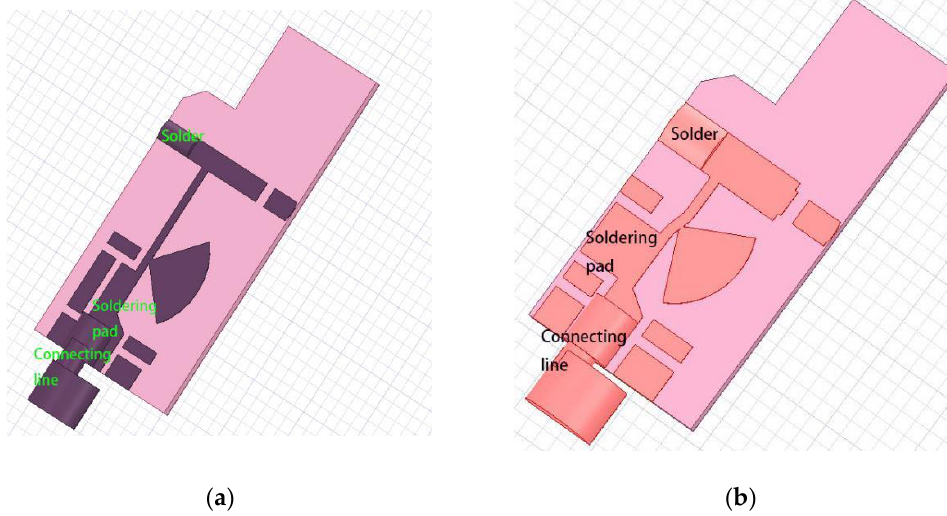
Figure 9. The simulation’s structural diagram of the traditional bias circuit and the proposed bias circuit. ( a ) The traditional bias circuit. ( b ) The proposed bias network. The parasitic inductance of the proposed and traditional bias circuits is illustrated in Figure 10a varying with frequency. Figure 10b illustrates the ratio of the parasitic induct- ance of the proposed bias circuit to that of the traditional bias circuit as a function of fre- quency. The abscissa of Figure 10a,b is logarithmic. The parasitic inductance of the pro- posed bias circuit is about 62% of that of the traditional bias circuit.